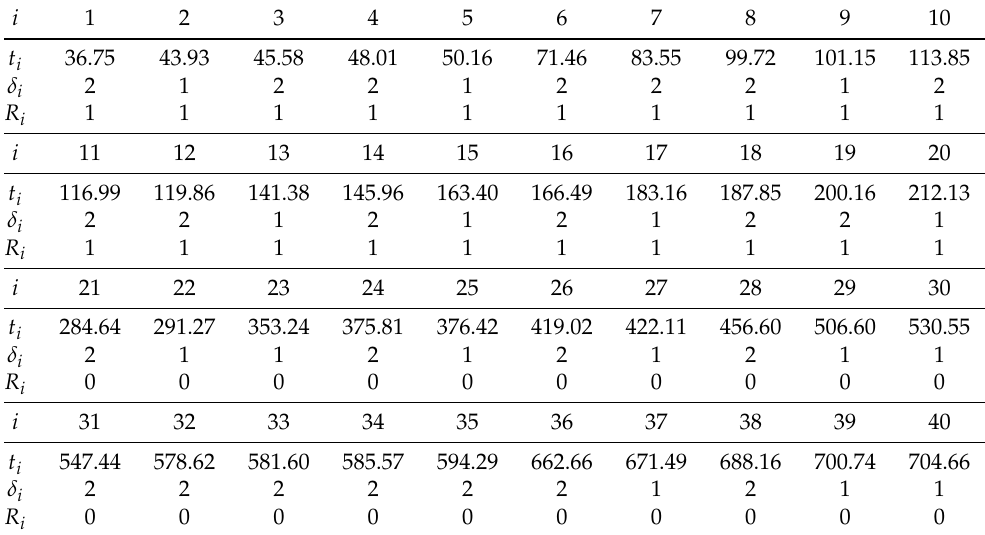
Table 1. Generated progressive Type-II competing risks sample from data of Xia et al. [33].